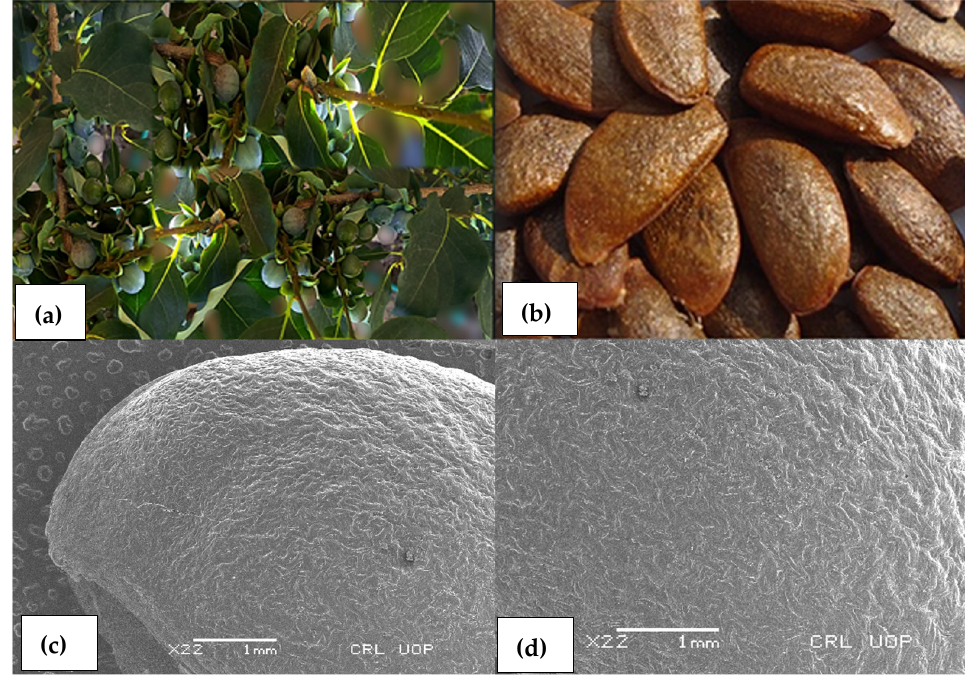
Figure 5. Diospyros lotus ( a ) plant, ( b ) seeds, and ( c , d ) SEM micrograph of seed sculpturing.